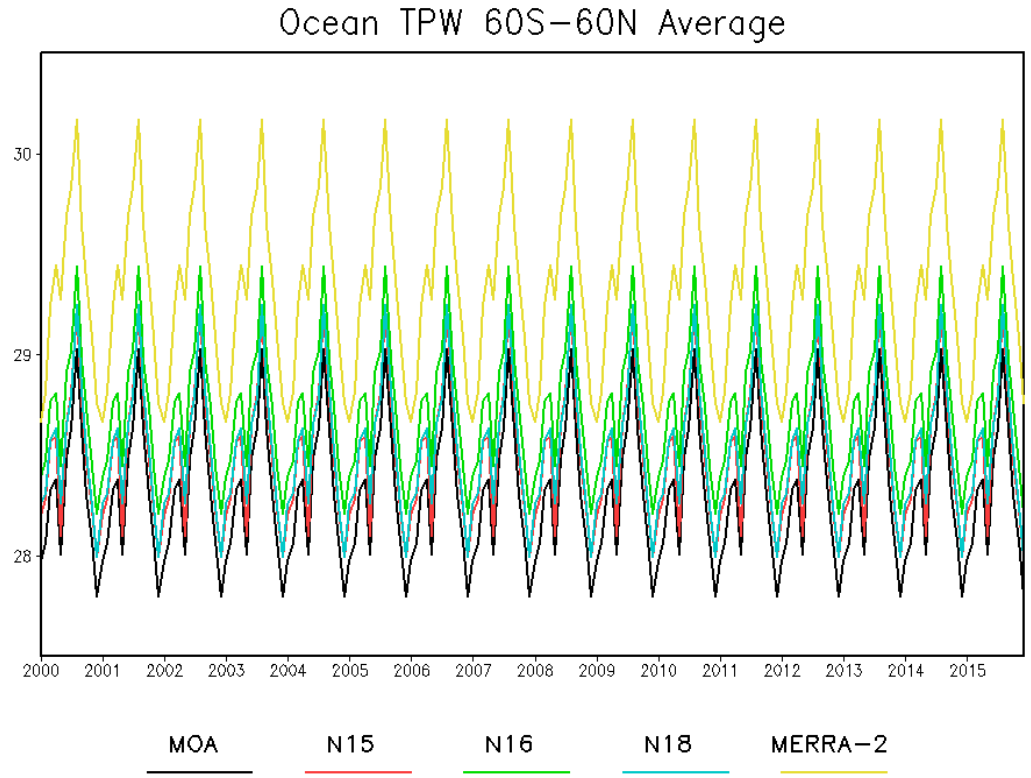
Figure 6. Time series of monthly mean TPW (mm) for each satellite in the HBC and MERRA-2 for the band between 60°S and 60°N.